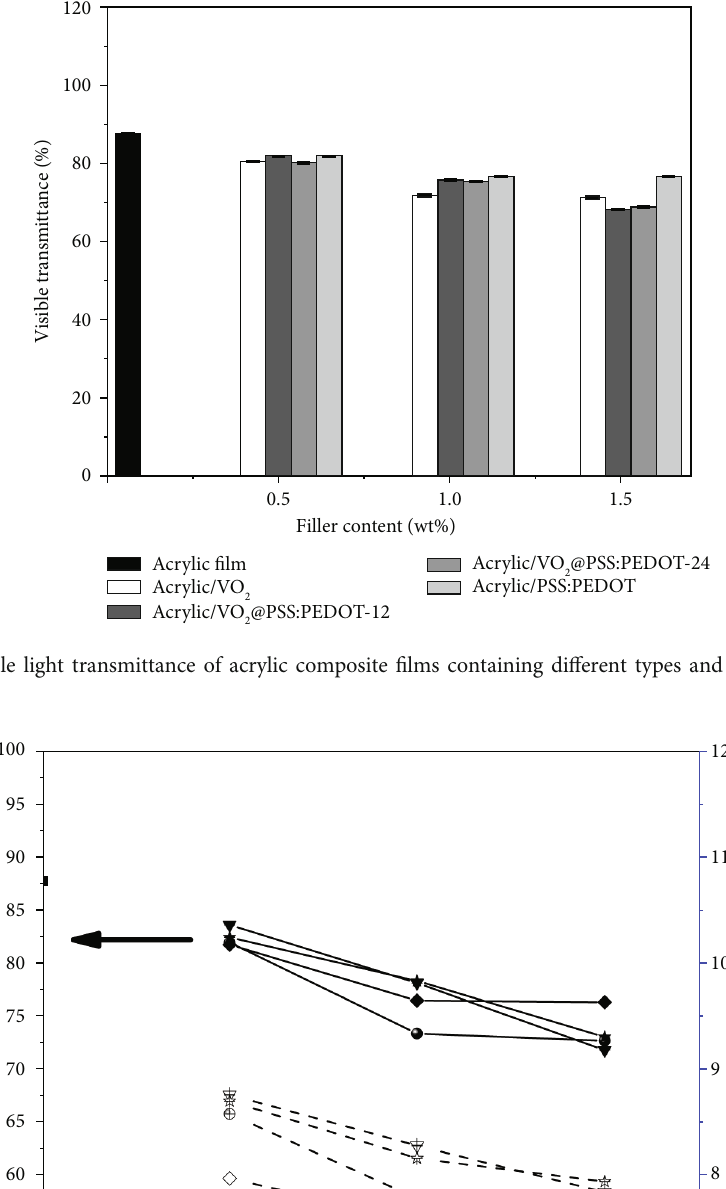
Figure 13: Percentages of near infrared (NIR) transmittance and NIR re fl ectance of acrylic composite fi lms containing di ff erent types and concentrations of VO -based 2